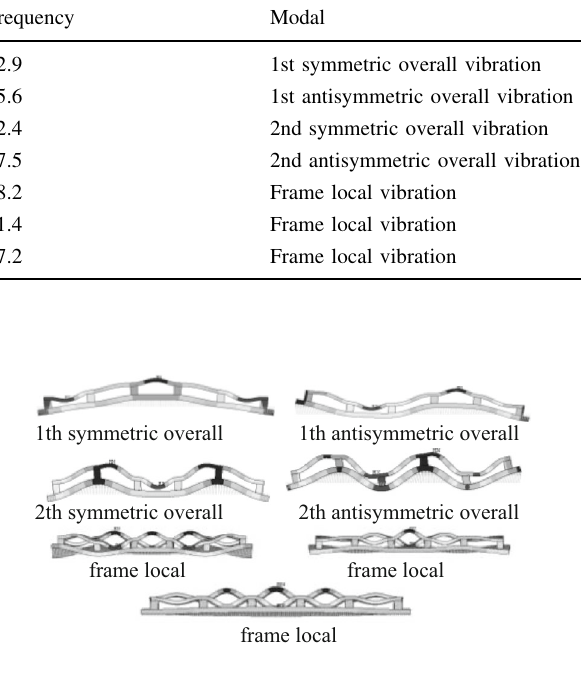
Fig. 7 The typical modal of at-ground structure